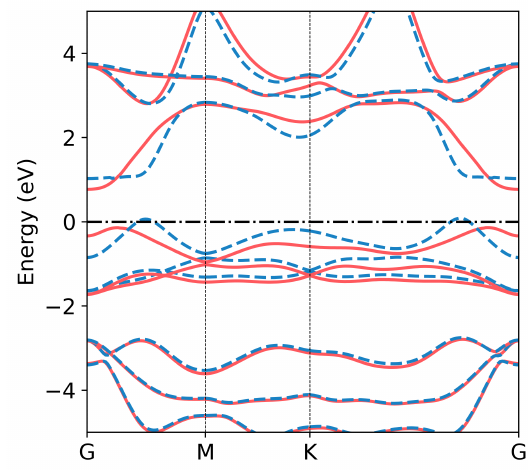
Figure 10: QSGW band structure of the monolayer LiCoO